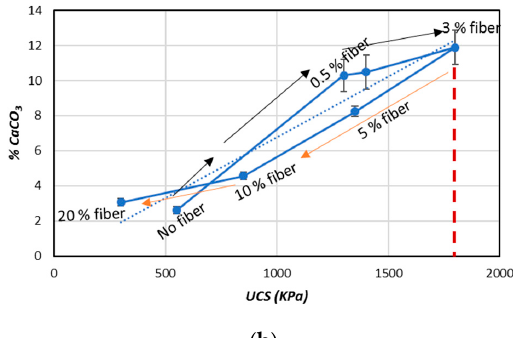
Figure 11. Average (%) CaCO 3 values for the biocemented sand sample after MICP treatment with the addition of jute fibers: ( a ) fiber length; ( b ) fiber content.